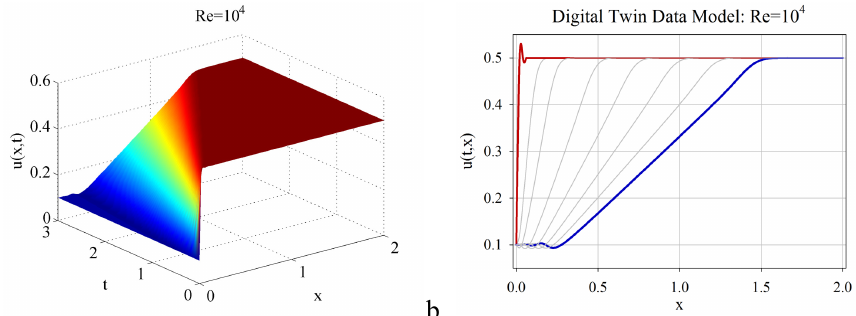
Figure 12. Solution of the digital twin data model in the case of experiment Re = 10 4 : ( a ) 3D view; ( b ) Projection view of the shock